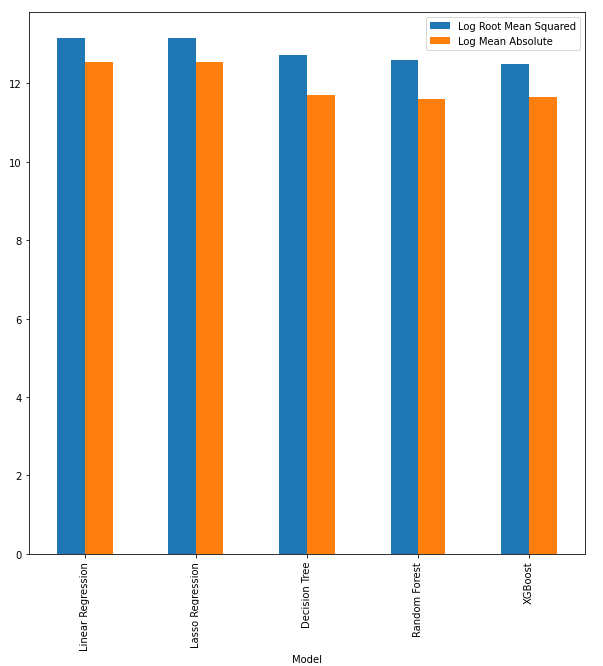
Figure 19. Comparison among log root mean squared error and log mean absolute error scores of the